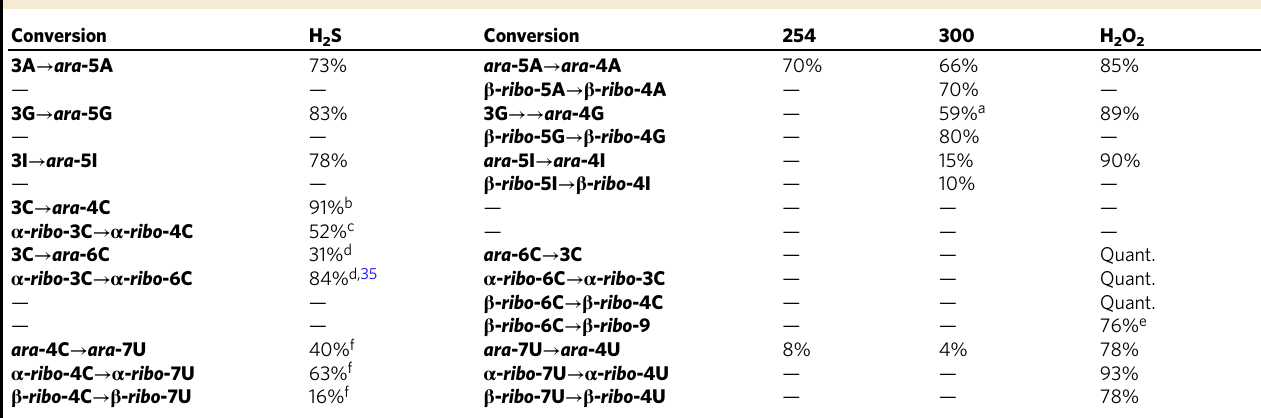
Table 1 Percentage conversions for nucleoside reactions Conversion H 2